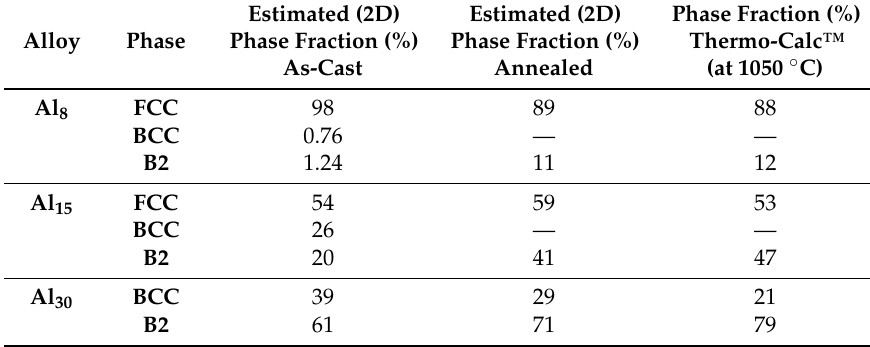
Table 2. Respective phases from each HEA along with the estimated phase fractions for the as-cast and annealed states. For comparison, the thermodynamically predicted phase fractions (at 1050 ◦ C) as predicted from ThermoCalc are also